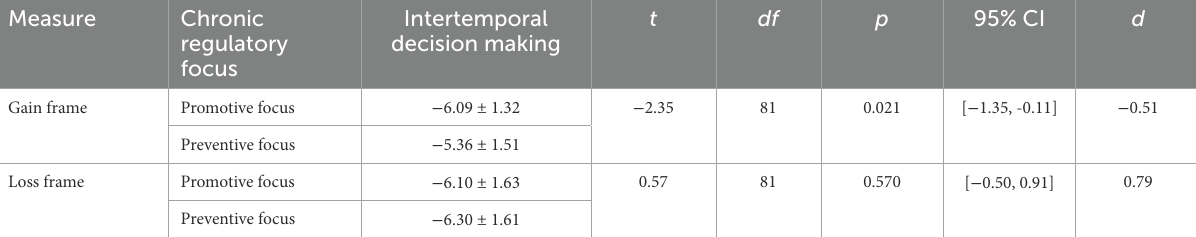
TABLE 2 An independent sample t -test for intertemporal decision making between promotive focus and preventive focus.